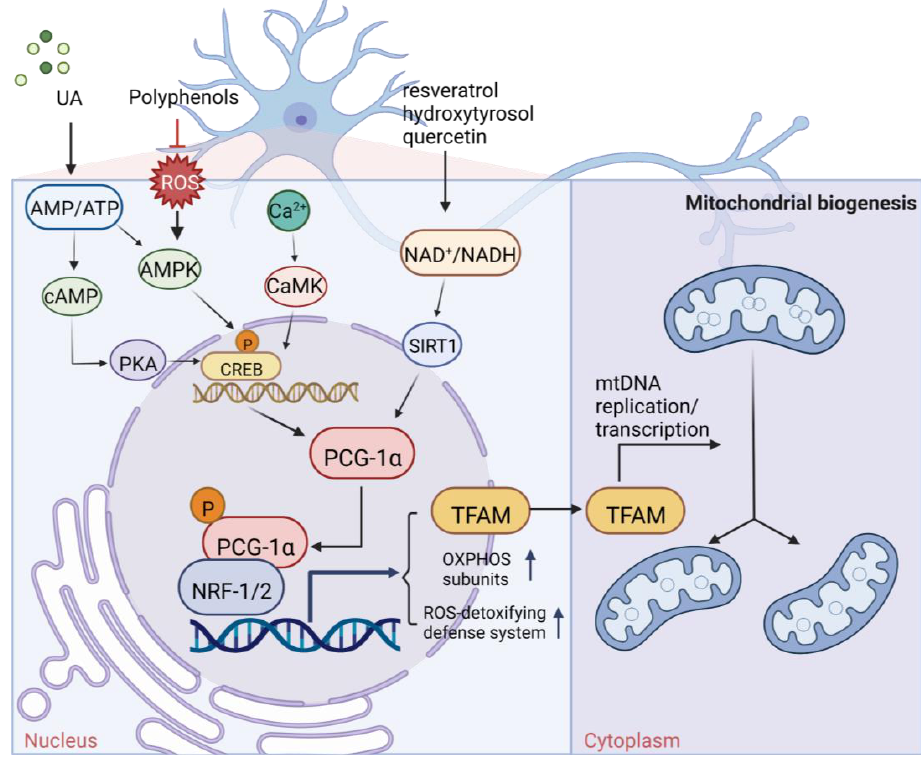
Figure 1. The mechanism of neuronal mitochondria biogenesis. The mitochondrial activity of neuron cells mainly depends on the expression of peroxisome proliferator activated receptor γ -coactivator 1 α (PGC-1 α ), which is determined by AMP/ATP ratio and Ca 2+ concentration. The NAD+/NADH ratio also participates in this pathway through Sirt1 deacetylation. Elevated concentrations of AMP and Ca 2+ promote the expression of certain kinases and activate PGC-1 α through direct and indirect phosphorylation. Subsequently, PGC-1 α binds to regulatory factors nuclear respiratory factor (NRF1/2) to promote the expression of certain system proteins, such as mitochondrial transcription factor A (TFAM), which promotes the transcription and translation of mtDNA and ultimately leads to increased mitochondrial biogenesis growth. Some natural products of plant origin, such as UA, polyphenols, resveratrol, hydroxytyrosol, and quercetin, can act on the cascade to improve mitochondrial